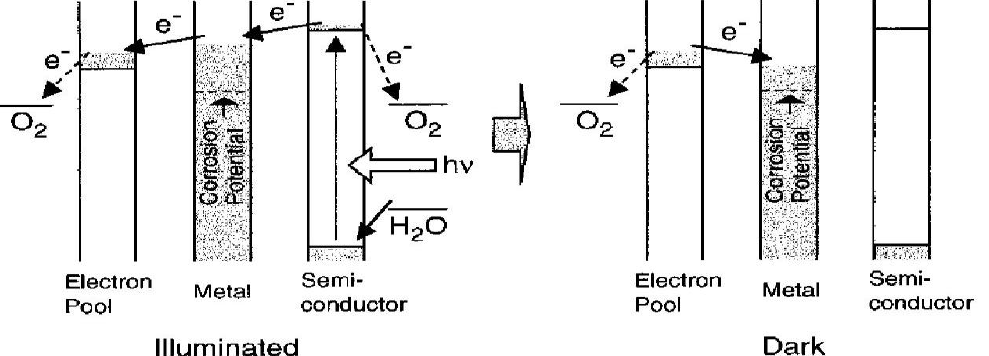
Figure 10. Mechanism of a photoelectrochemical anticorrosion system with an energy storage ability [22].